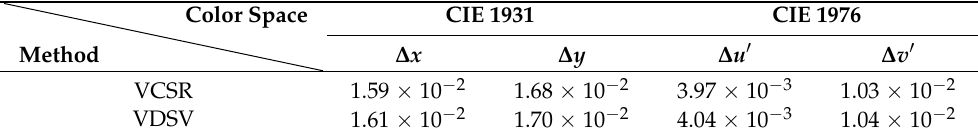
Figure 16. Measured CIE 1976 chromaticity diagrams with: ( a ) VCSR method; ( b ) VDSV method. Table 5. Maximum change of color space coordinate axis measured with the studied methods.